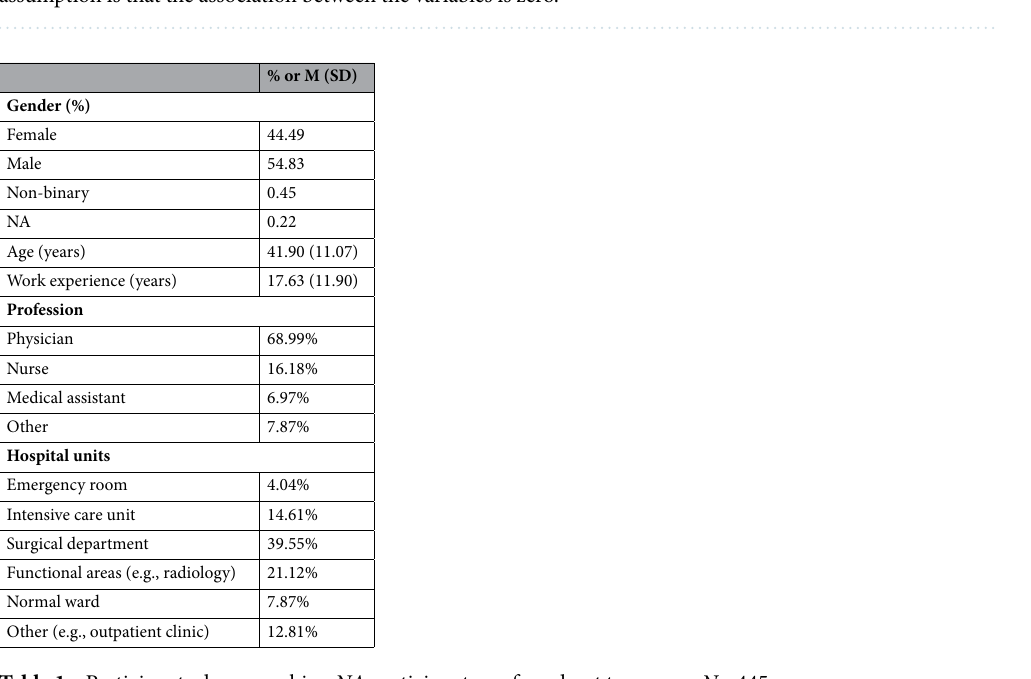
Figure 1. Depiction of the proposed structural equation model. The direction of the assumed association is indicated by + for a positive association or by − for a negative association. The null hypothesis for each assumption is that the association between the variables is zero.